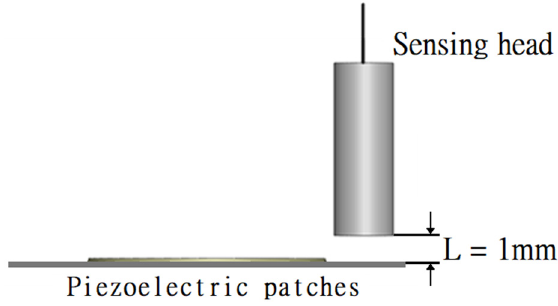
Figure 3. Schematic diagram of jet path.